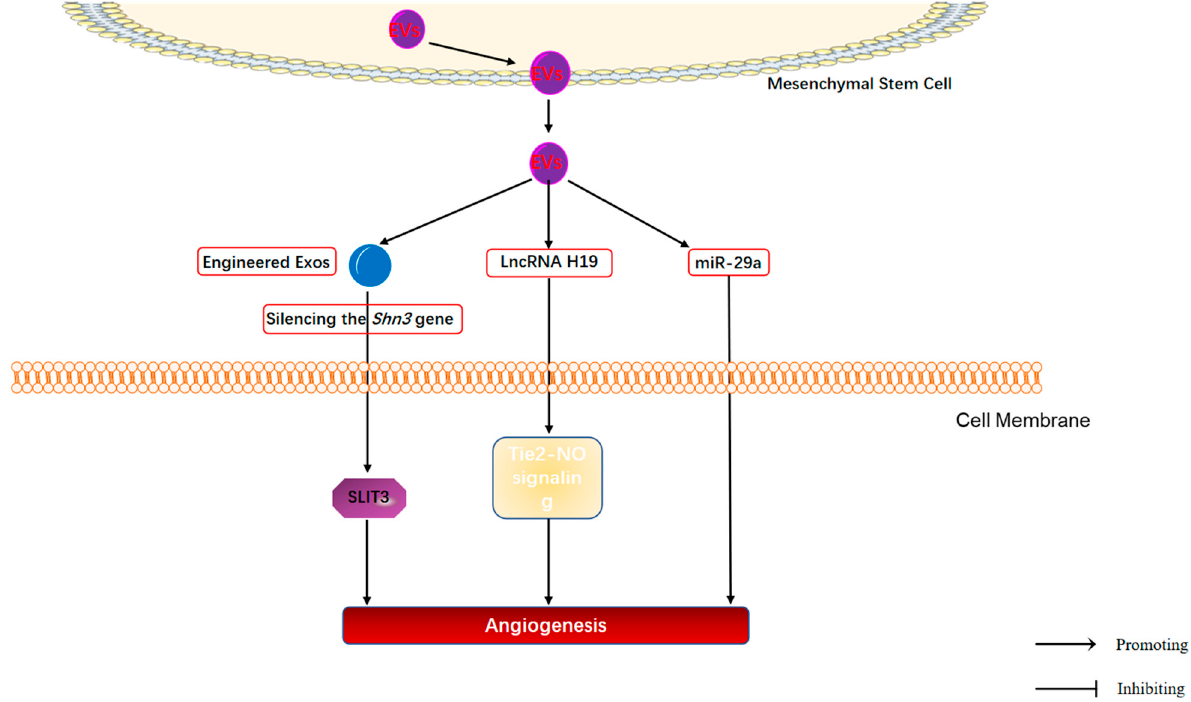
Figure 4. Mechanisms of MSC-EVs regulating the angiogenesis in OP.